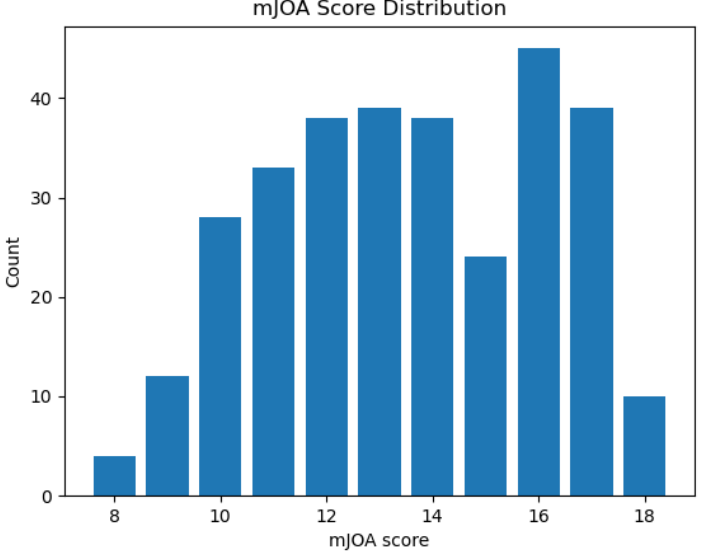
Figure 5. A box plot showing the number of individuals in our study with any given mJOA score. Although not quite ideal, this distribution is relatively balanced across the mid-range of mJOA scores. Note as well that extreme values (mJOA = 18 and mJOA = 8, 9) are rather rare, as would be expected given the acquisition method we used (data taken from those diagnosed with DCM who were undergoing initial assessment).